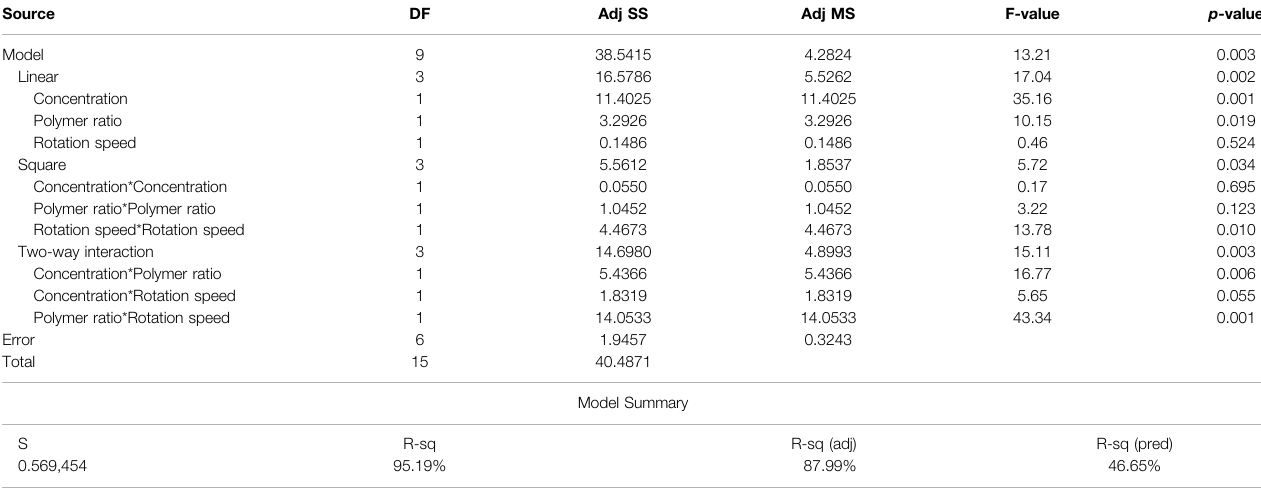
TABLE 4 | Analysis of variance for strain.